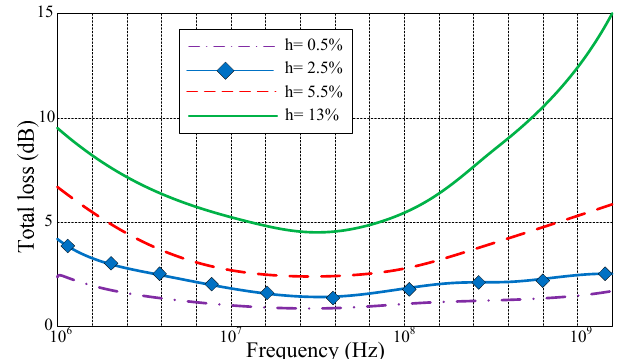
Figure 1. Total loss of electromagnetic wave penetrating concrete.